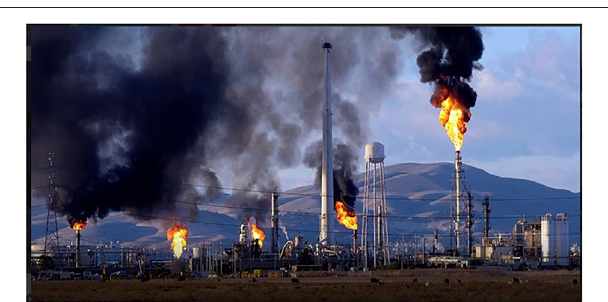
FIGURE 1 | Typical pollution of the environment from a re fi nery (https:// africanclimatereporter.com/2019/06/05/environment-day-climatologist- tasked-industry-company-re fi nery-owners-in african-on-mandatory-trees-